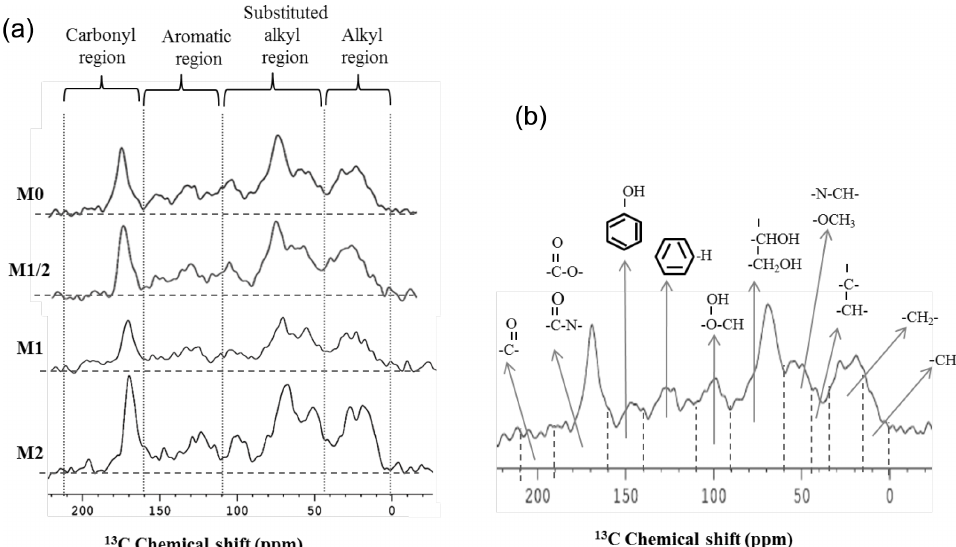
Figure 2. CPMAS 13 C-NMR spectra of 10% HF pretreated SOM. (a) CPMAS 13 C-NMR spectra of 10% HF pretreated SOM under different long-term mowing managements. (b) Detailed C functional groups in different chemical